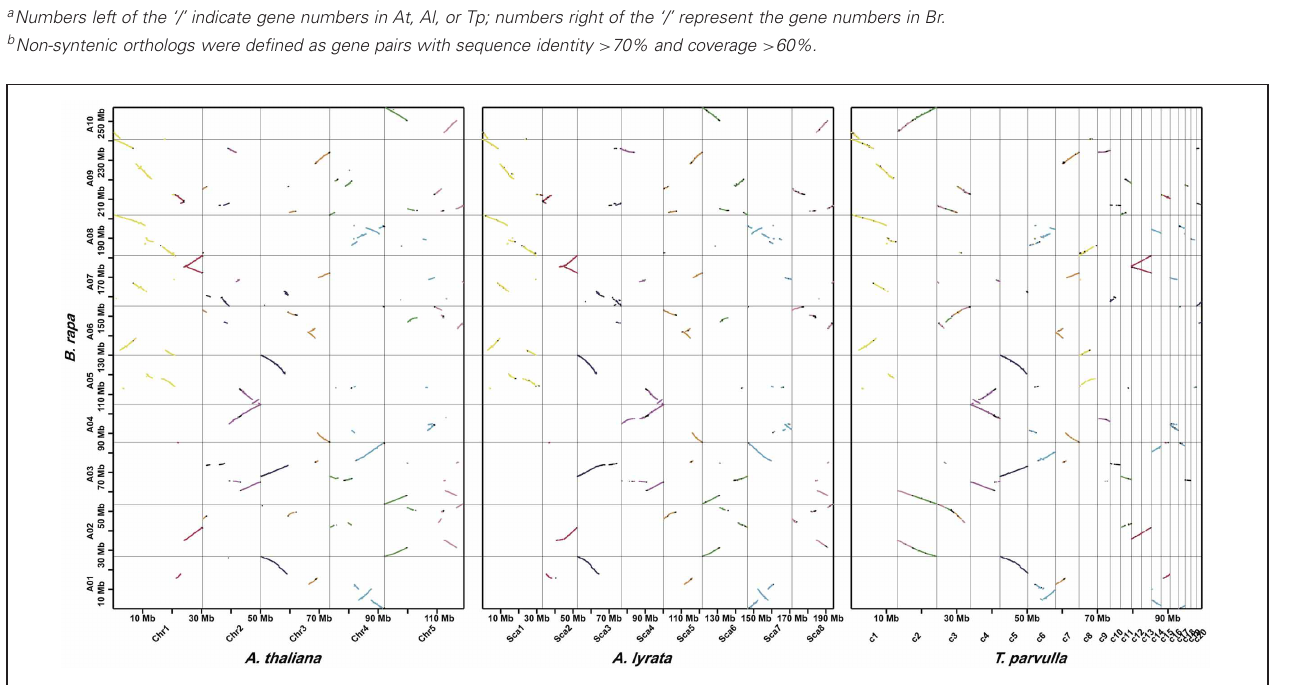
FIGURE 3 | Syntenic genes identified by SynOrths between B. rapa and A. thaliana , A. lyrata , or T. parvula . For each segment in A. thaliana , A. lyrata , or T. parvula , there were three syntenic copies observed in B. rapa, which clearly reflected the genome triplication experienced by B. rapa . Colors of the dots represent for the 24 ancestral blocks of Brassicaceae species, which has been defined previously (Schranz et al.,